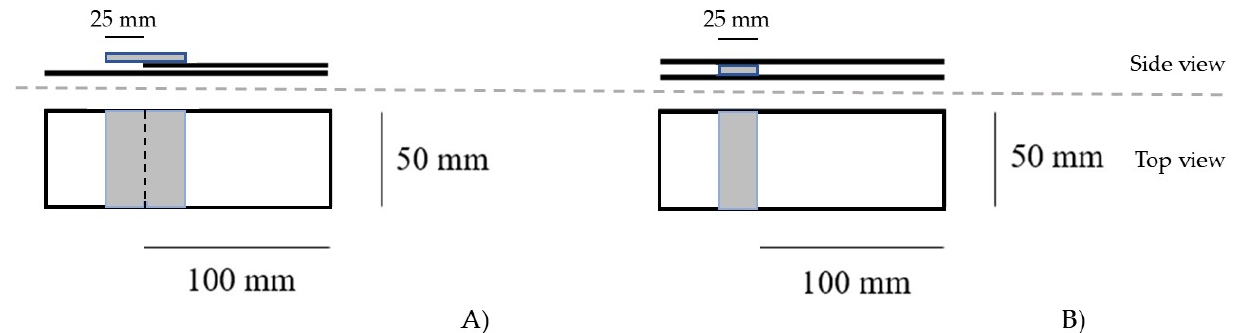
Figure 8. ( A ) assembly with single-sided adhesive tape, ( B )